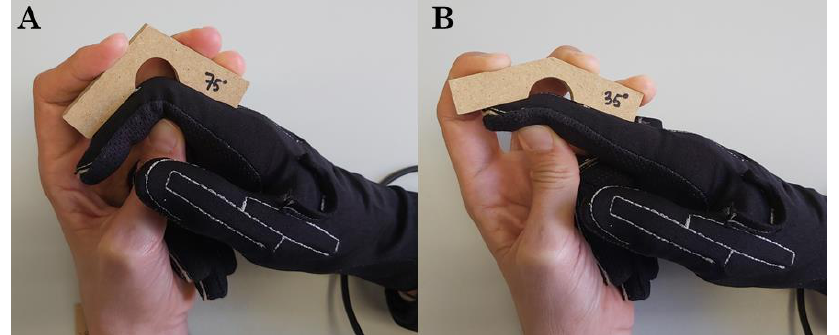
Figure 3. Controlled static postures recorded using wooden pieces. ( A ) Controlled static postures recorded using wooden pieces of 75 ◦ . ( B ) Controlled static postures recorded using wooden pieces of 35 ◦